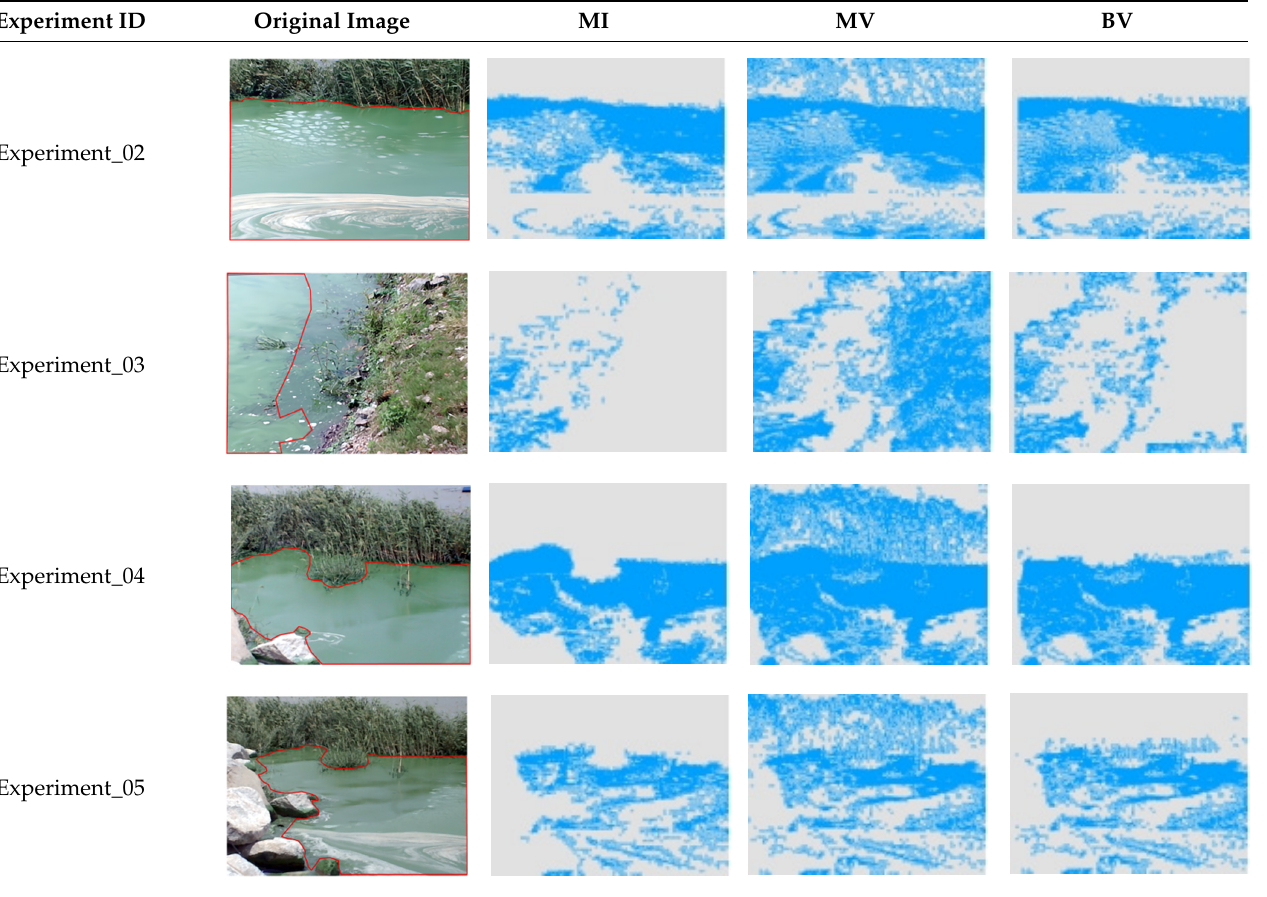
Table 1. Cont. Original Image MI MV BV